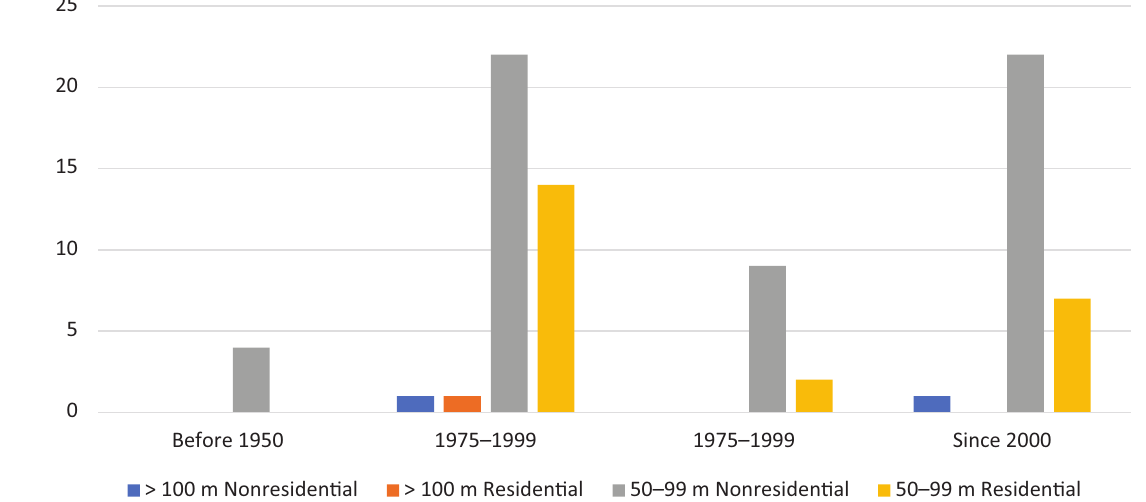
Figure 2. Construction of tall buildings (50 m and above) in Hamburg. Sources: Author’s work based on personal observa‐ tions, Hamburg (2022), Hilgenstock (2011), Wikipedia (2022b), and Zabel (2020).